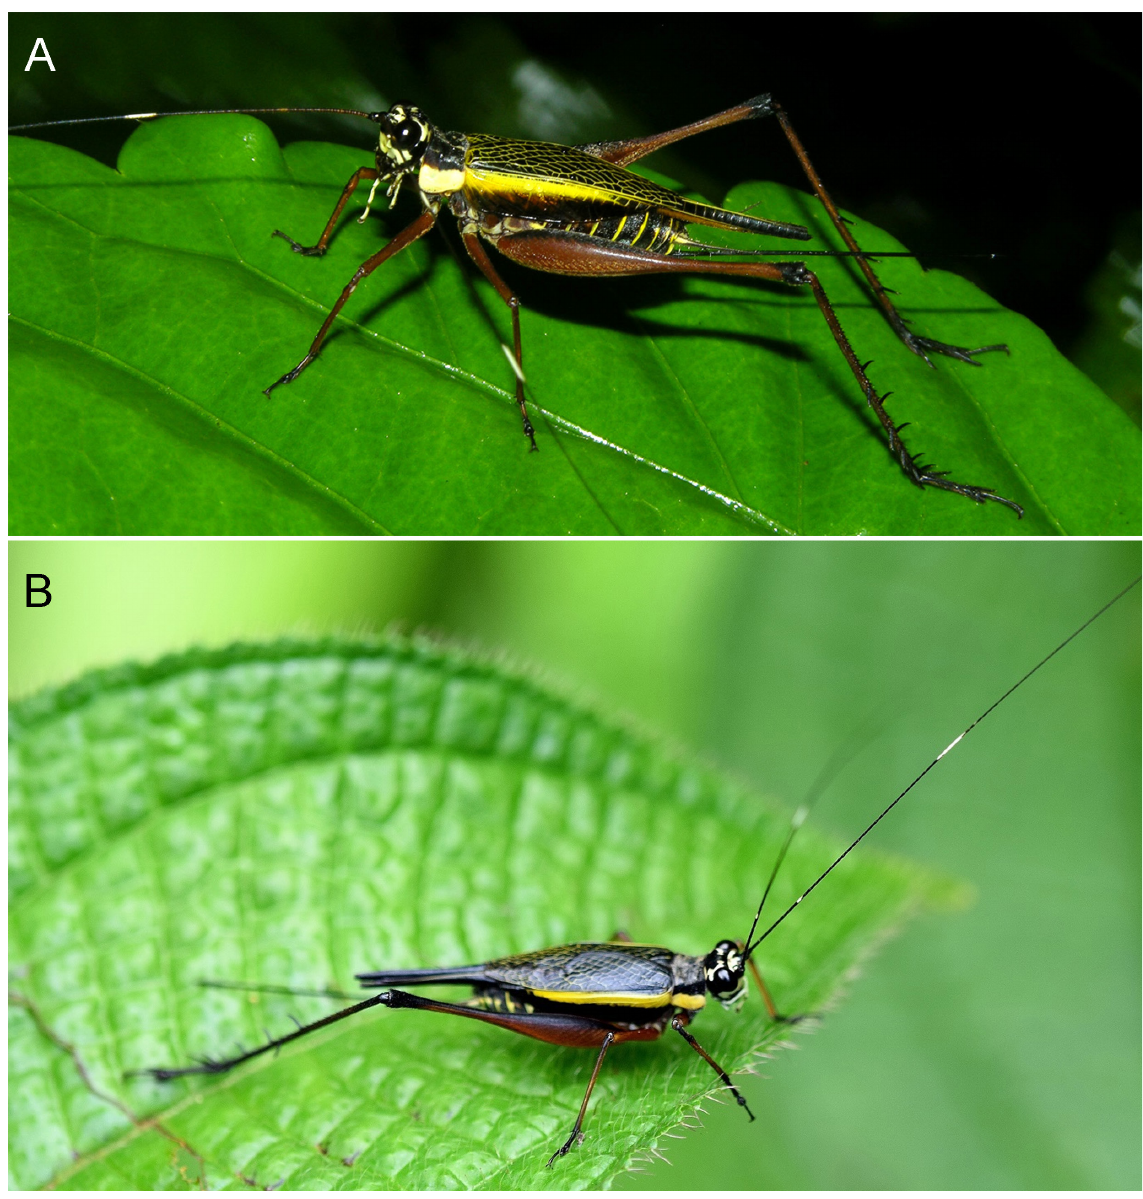
Fig. 19. Nisitrus danum Robillard & Tan sp. nov., adult ♀♀ in their natural environment. Photograph source and credits: iNaturalist; Arthur Anker (A), Charlie Elder